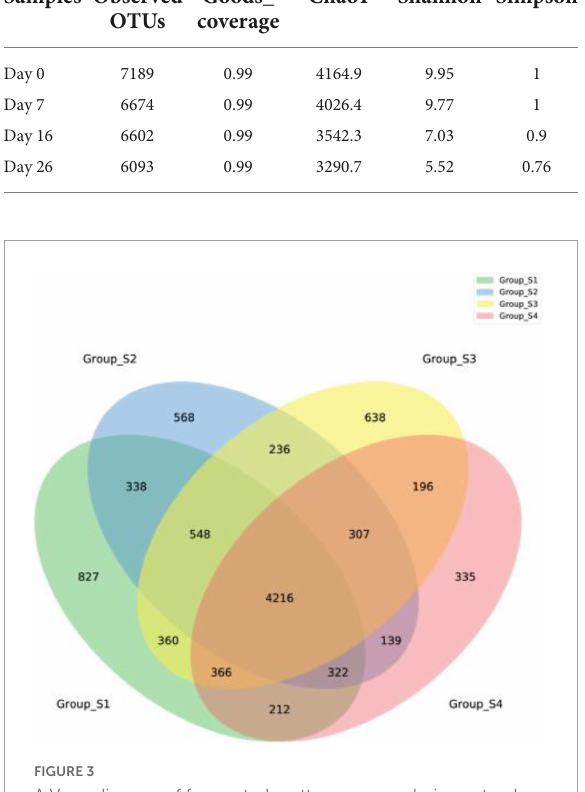
0.6 to 2.8 mg MDA/kg fermented sausages suggested by Marco et al. (2006). The nitrite ion concentration fell